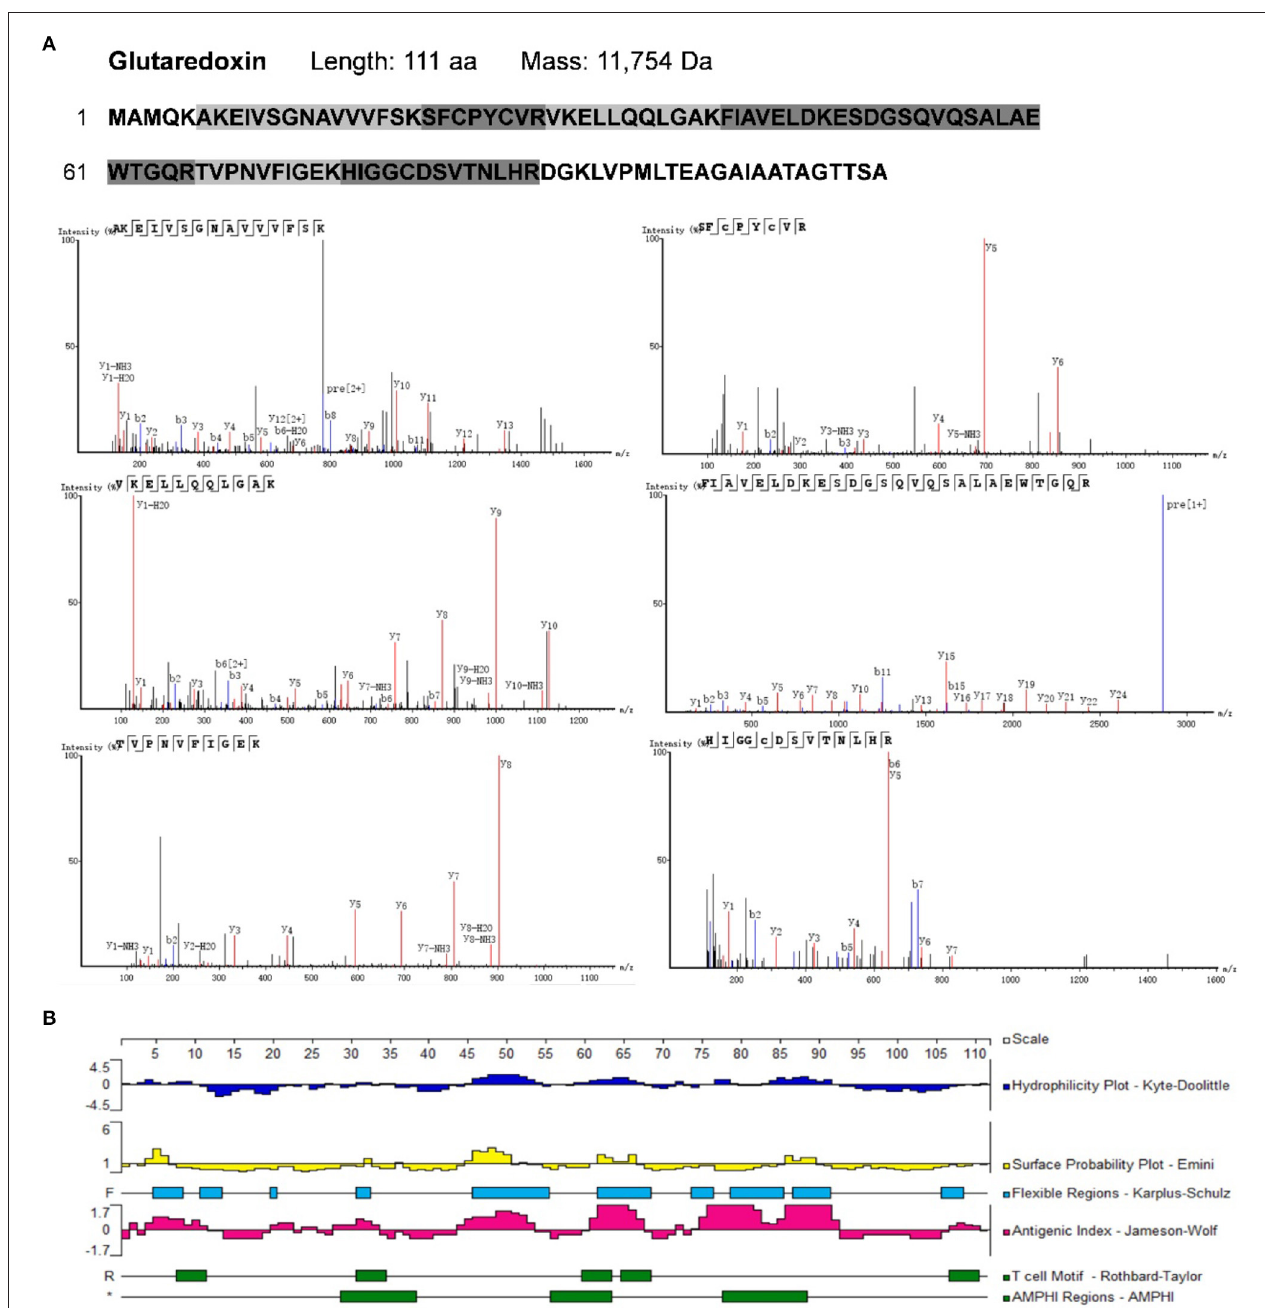
FIGURE 1 | (A) The amino acid sequence of glutaredoxin containing the shade parts which indicated the identified amino acid sequence fragments by proteomics analysis. The mass spectra of these identified amino acid sequence fragments were displayed. (B) Epitope prediction of Glutaredoxin for acting with T cells and B cells.